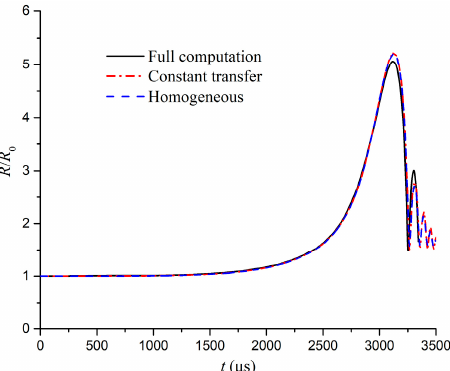
homogeneous model matches well with that by the constant-transfer model before bubble rebound.